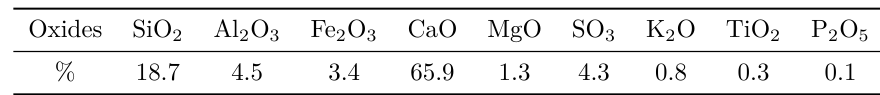
Table 1. Chemical analysis of CEM I 42.5 R (% by weight).